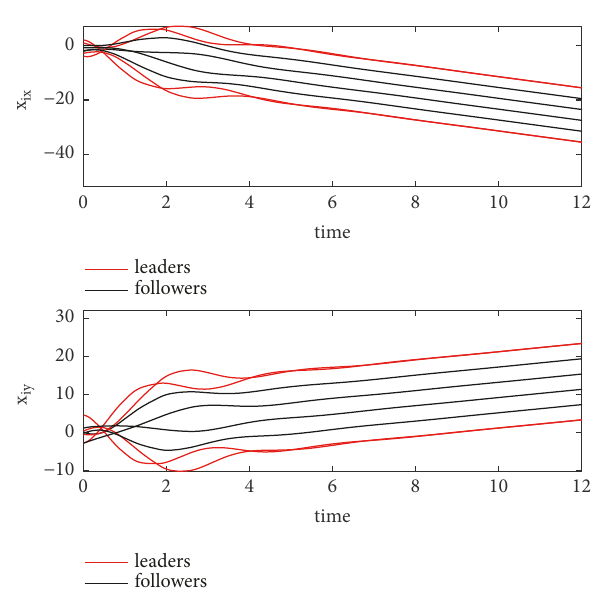
Figure 2: Network of eight agents.